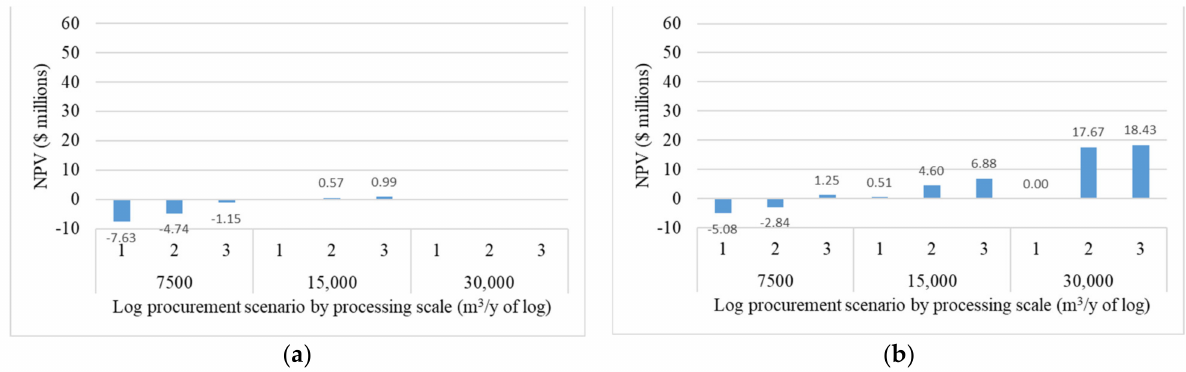
Figure 2. NPV for integrated production of one-stage LVL. ( a ) Facility location A. ( b ) Facility location B.